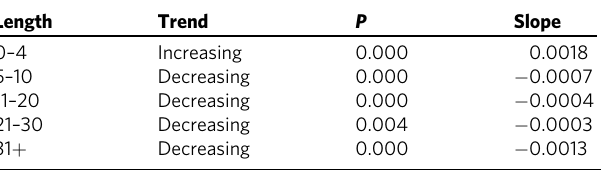
Table 2 Results of the Mann-Kendall trend tests on the MDDs of sentences with different